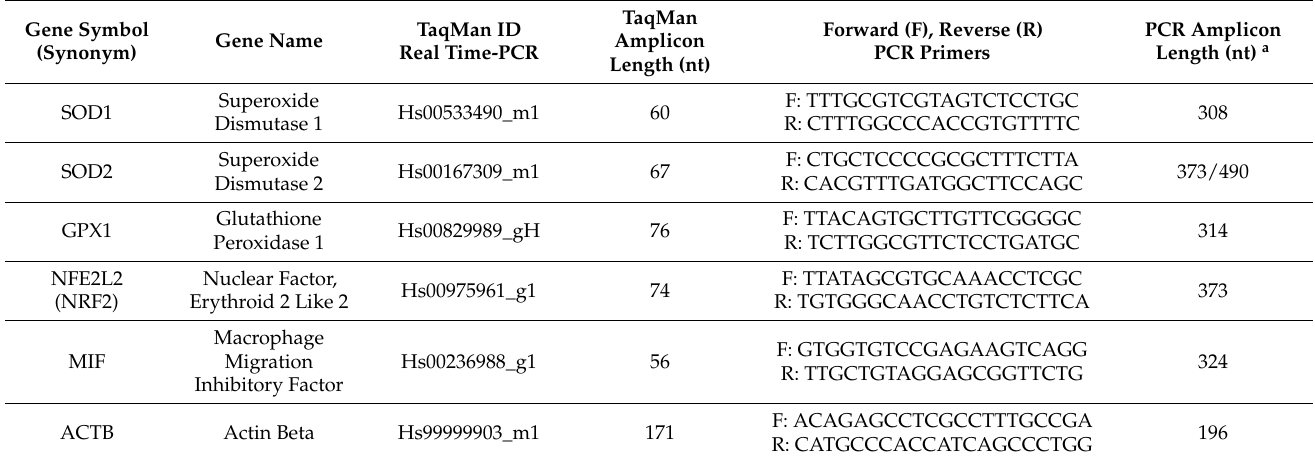
Table 1. RT-PCR on selected genes that participate in the cell redox